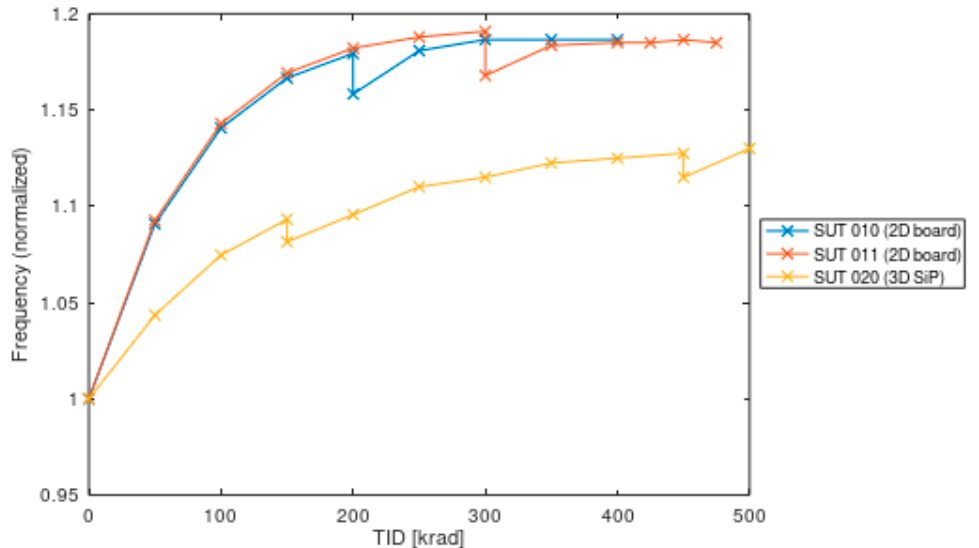
Figure 4. Normalized oscillator frequency value as a function of TID for 2D boards and 3D SiP. (notches observed in each curve (e.g., at 200 krad for SUT 010 curve) are due to annealing, when irradiation had to be stopped for a longer period (e.g., whole night)).